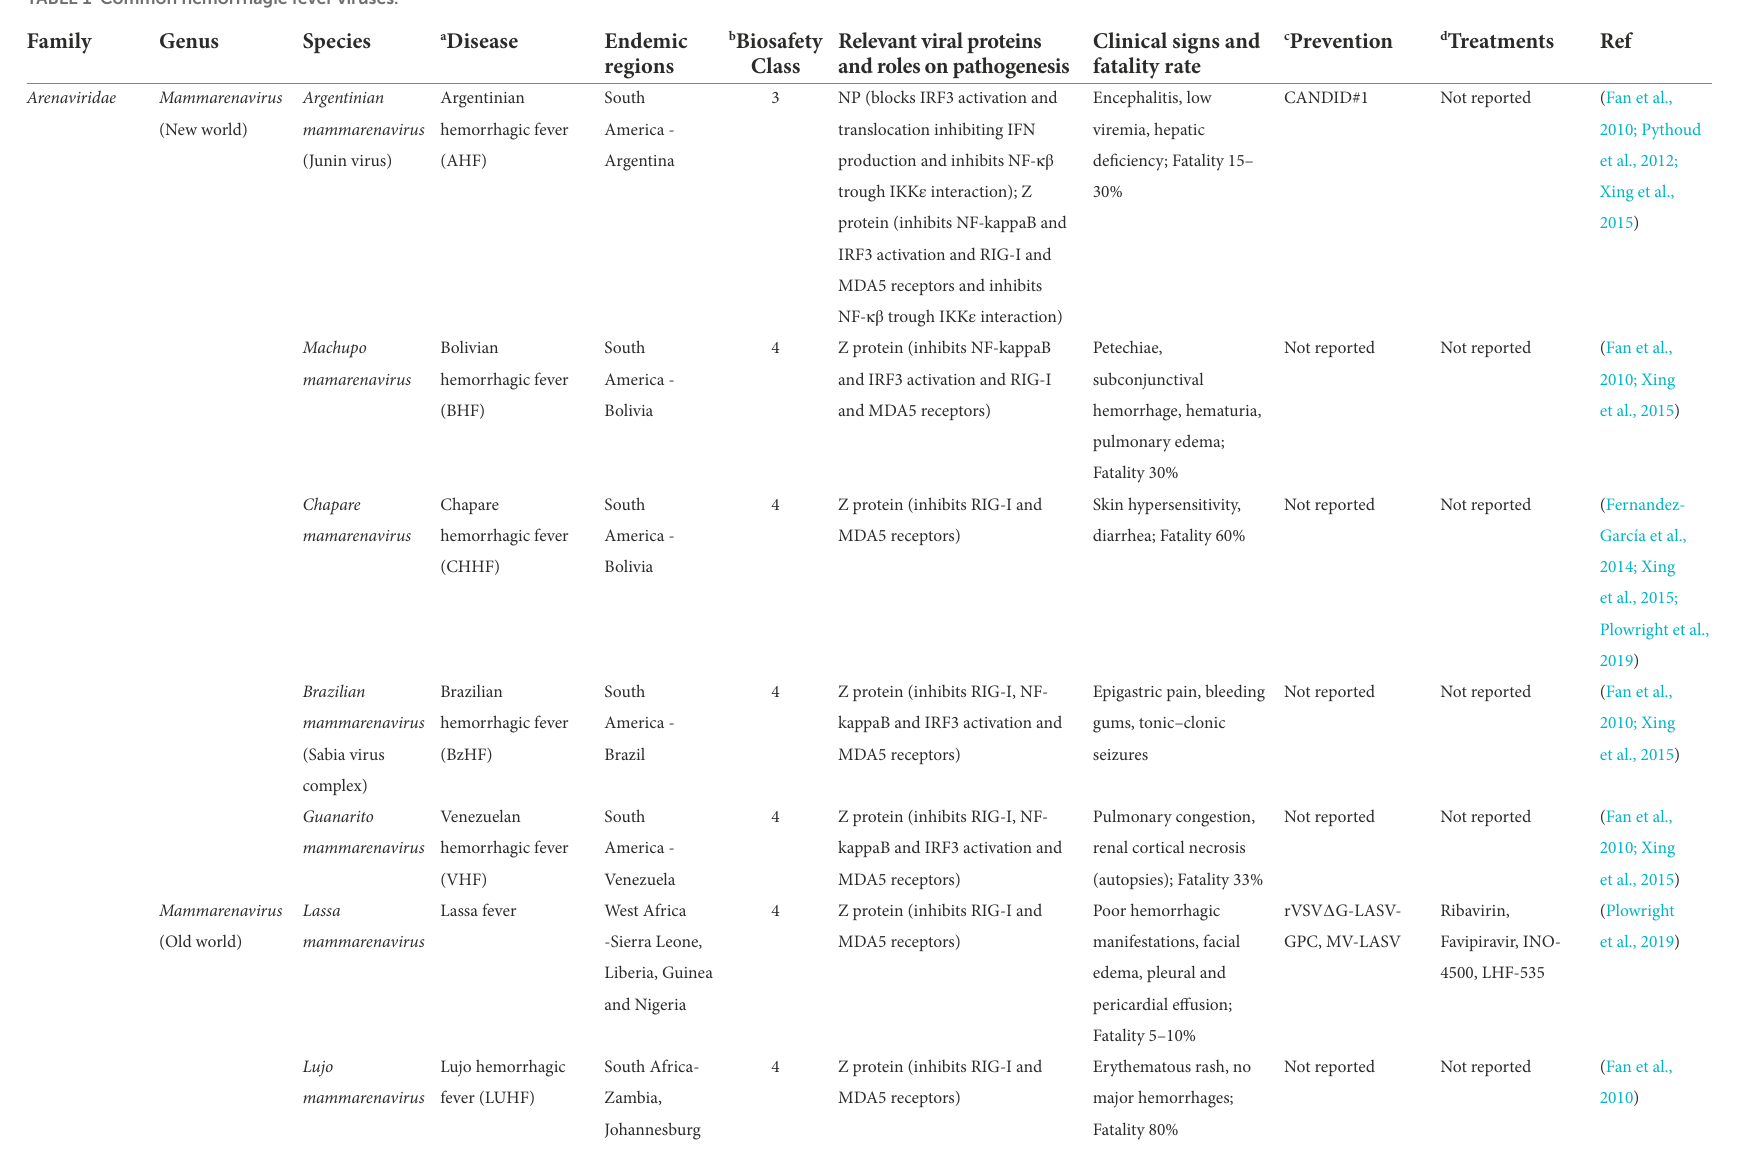
TABLE 1 Common hemorrhagic fever